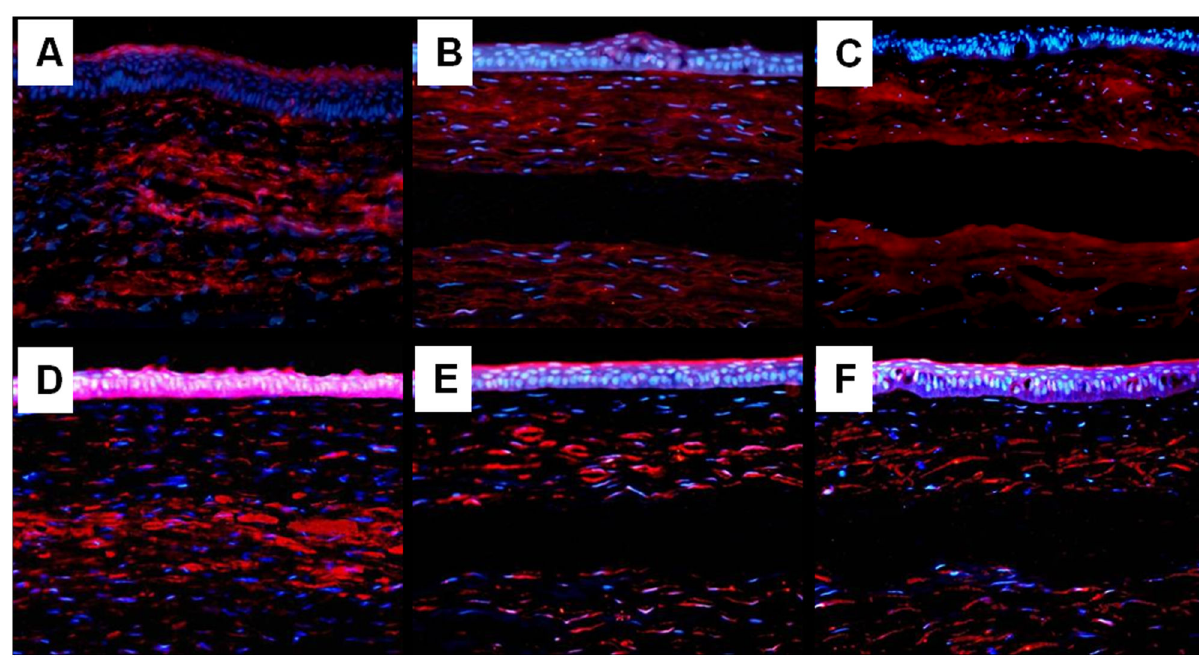
Figure 7. Rabbit keratocan and ALDH1A1 expression in each group at 24 weeks post-implantation. A, B, C: keratocan; D, E, F: ALDH1A1. (A, D) cornea implanted with autologous rASCs-PLGA constructs; (B, E) cornea implanted with PLGA alone; (C, F) cornea with defect only. (A-C) expression of keratocan; (D-F) expression of ALDH1A1. Both keratocan and ALDH1A1were positioned in the implanted layer of corneas implanted with the rASCs-PLGA complex, while the result was negative in corresponding layers in groups implanted with PLGA alone and defects only (Magnification×200)..